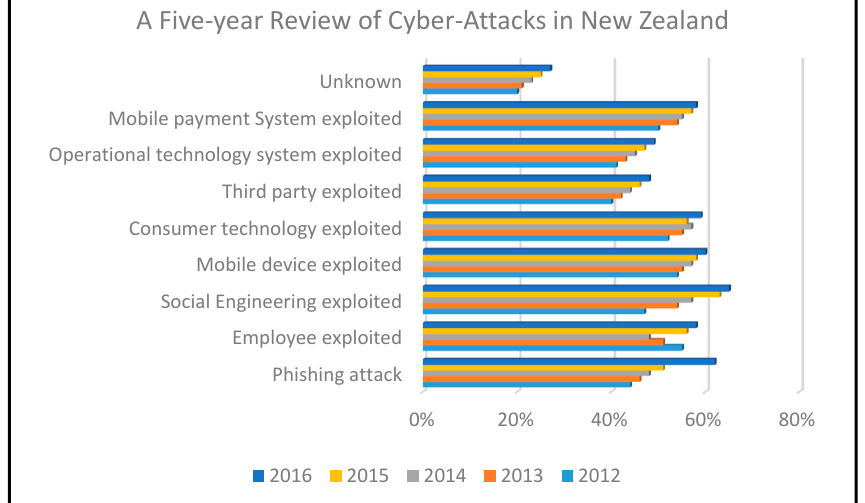
Figure 3. New Zealand cyber-attacks: a five-year review [23].